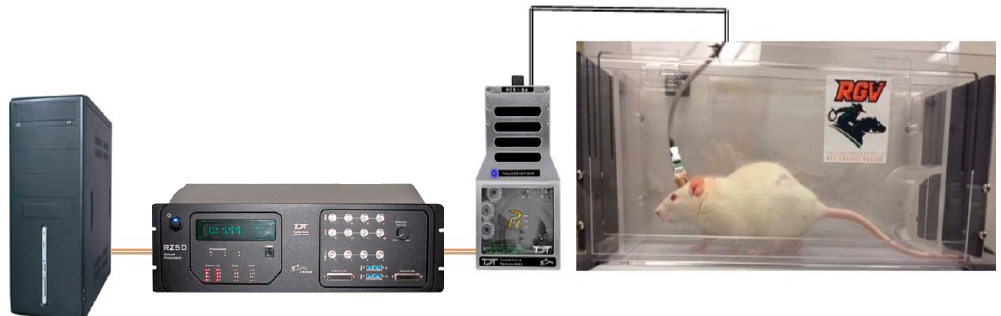
Figure 3. The acquisition system setting. One end of a TDT zif-clip digital headstage is connected to a headstage adapter on top of the rat’s head and the other end is connected to PZ5 amplifier to boost and digitize the signals. The acquired signals are transmitted through the noiseless fiber optic connection to the RZ5 BioAmp processor for further processing and then transferred to PC for the final